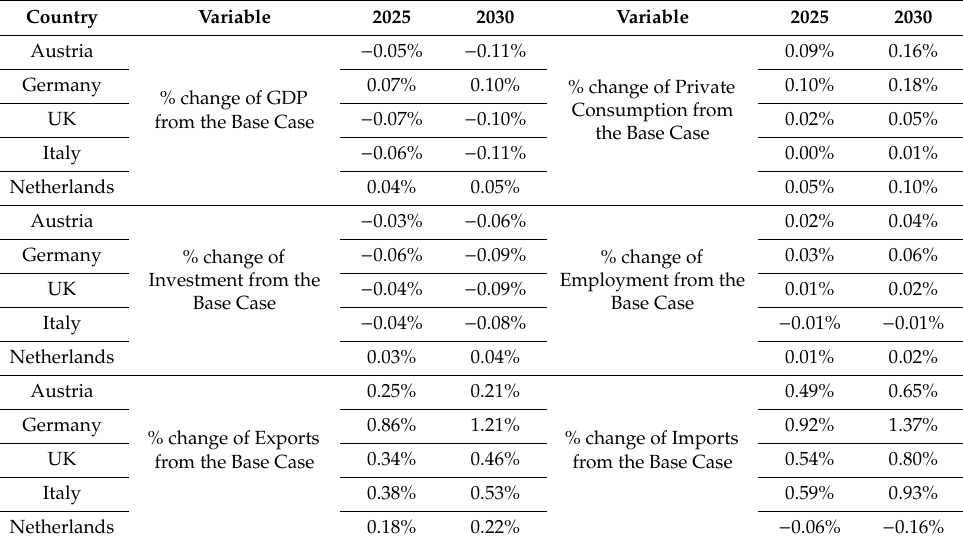
Table 6. Macroeconomic implications of the policy scenario at the country-wide